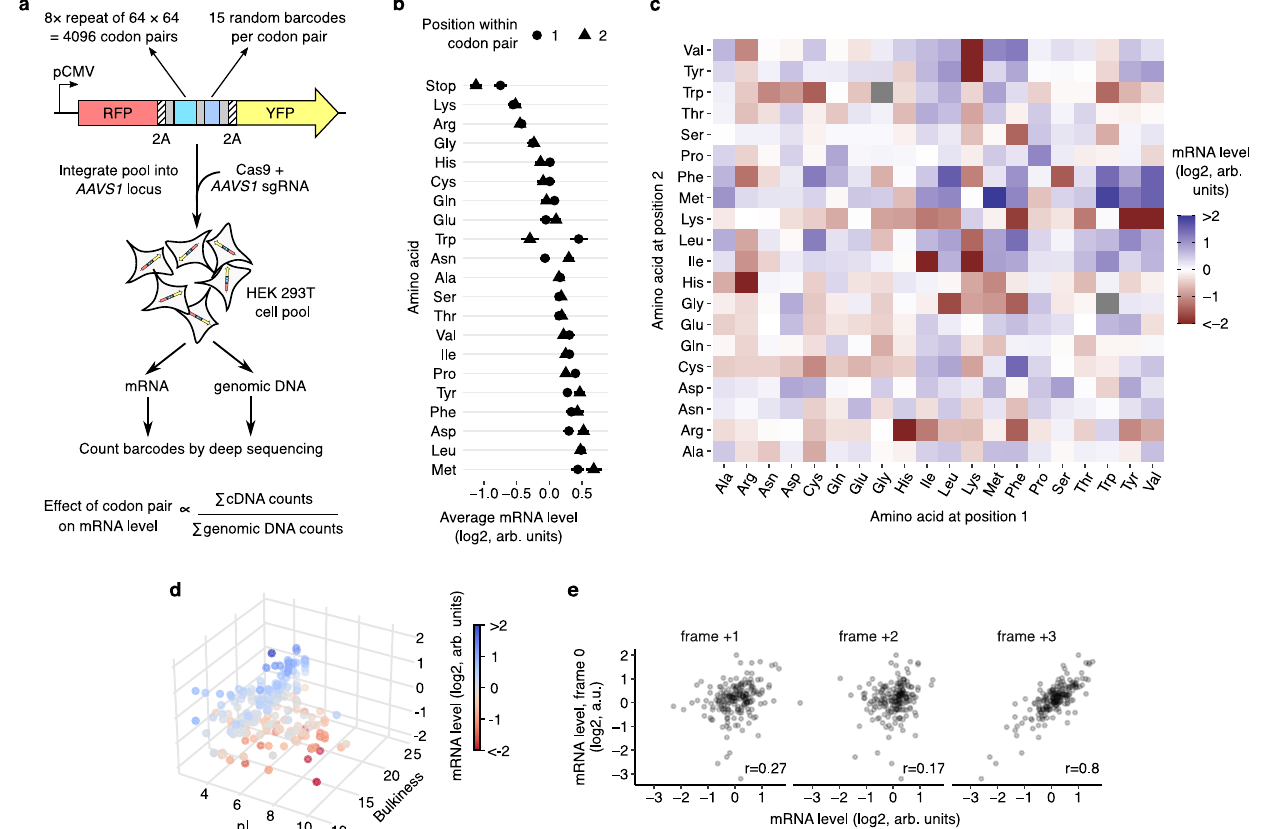
Fig. 1 | Dipeptide repeats reduce mRNA levels. a Schematic of massively parallel assay for measuring reporter mRNA levels. 8× repeats of all 4096 codon pairs are synthesized as pooled oligonucleotides, linked in-frame to 24nt random barcodes, and cloned between RFP and YFP reporters with intervening 2A sequences.